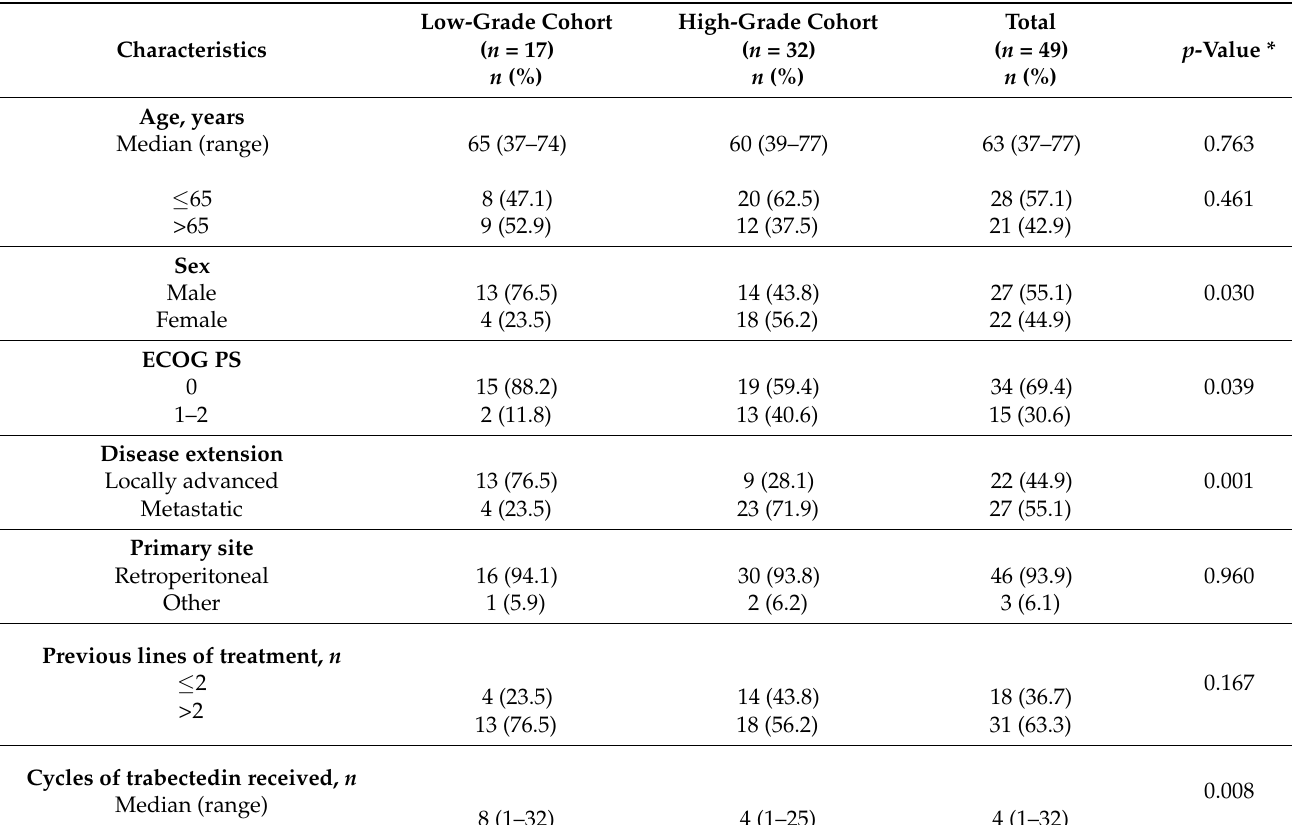
Table 1. Patients’ disease and treatment characteristics.